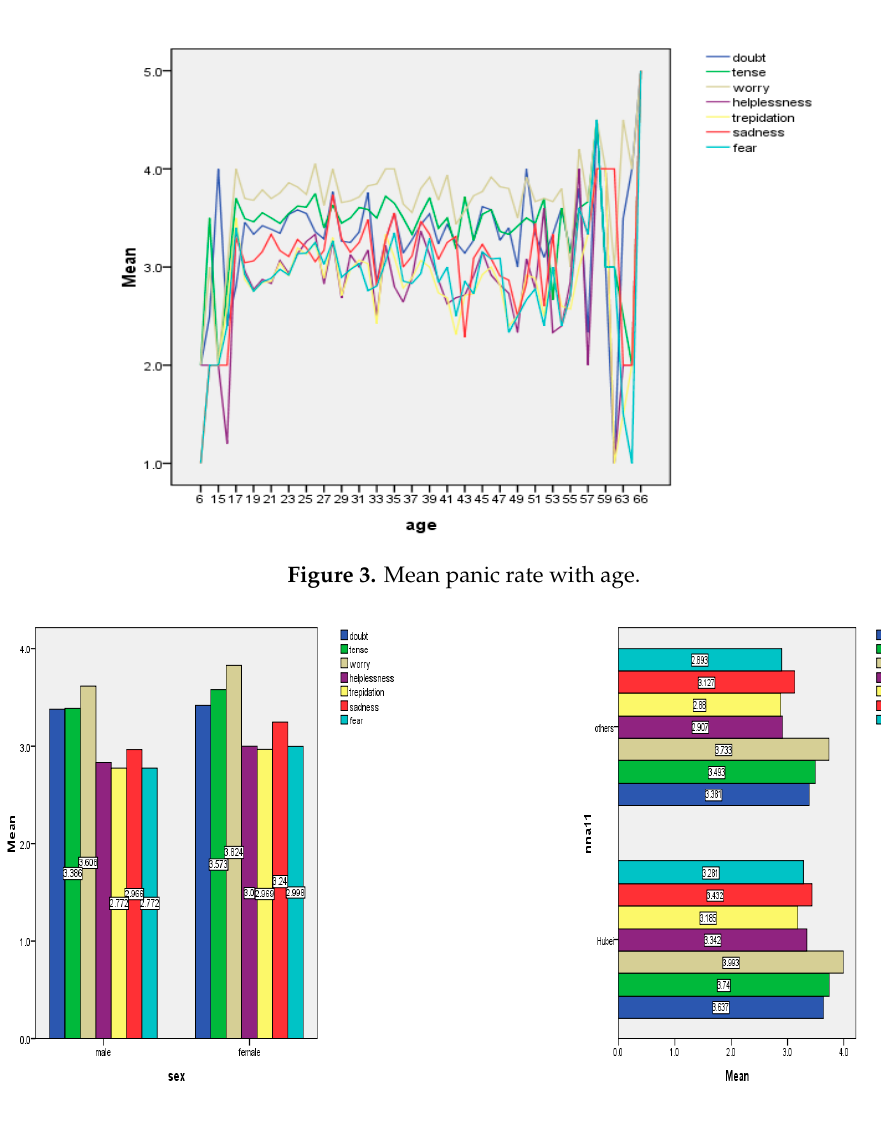
Figure 4. Comparison of panic between ( a ) different genders and ( b ) people in Hubei and other provinces in China.